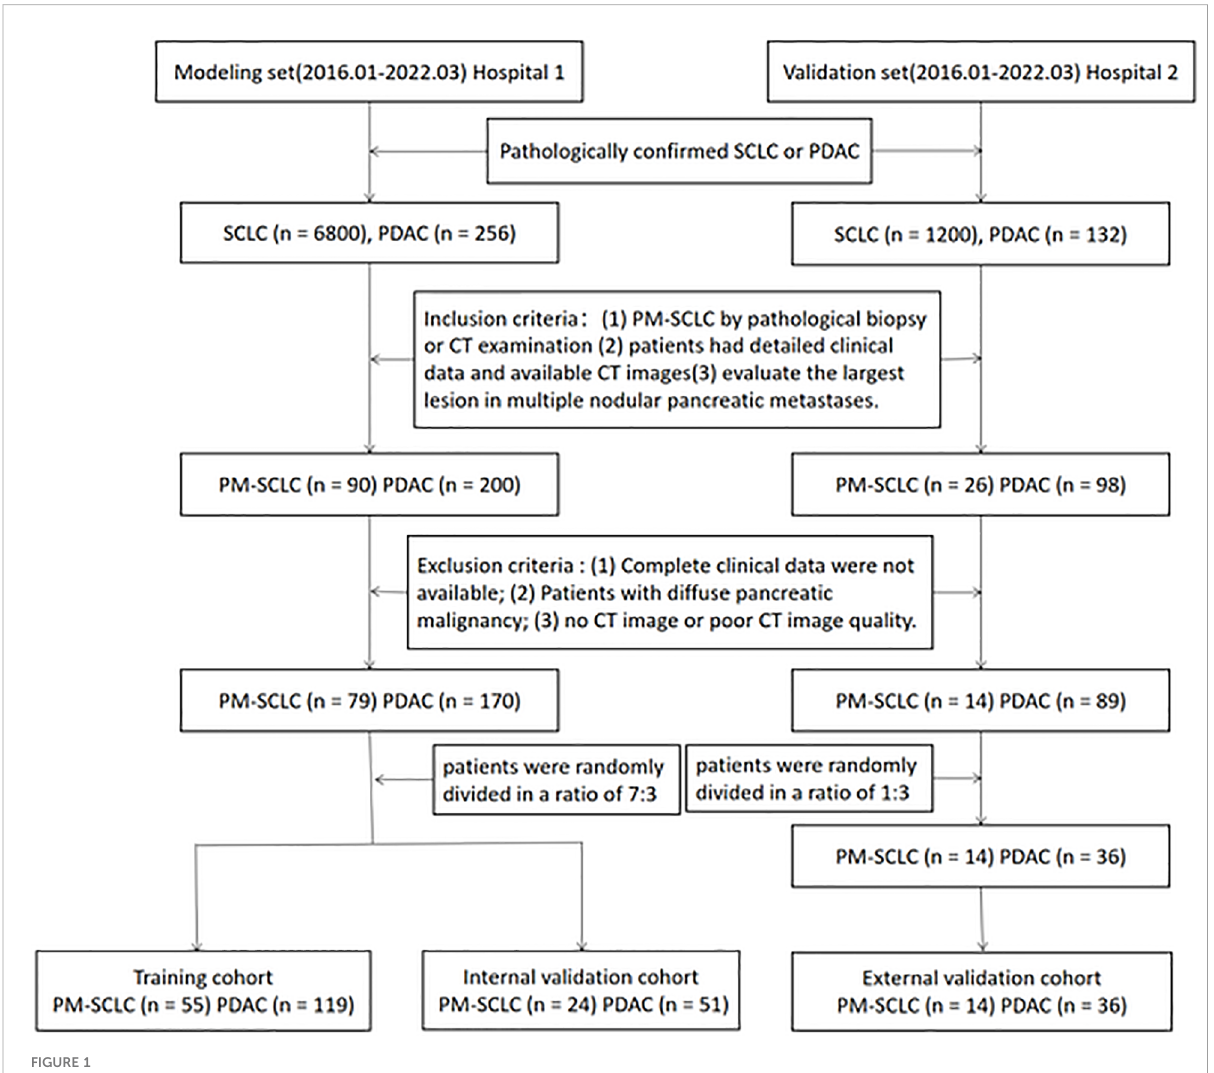
FIGURE 1 The fl owchart of the patient